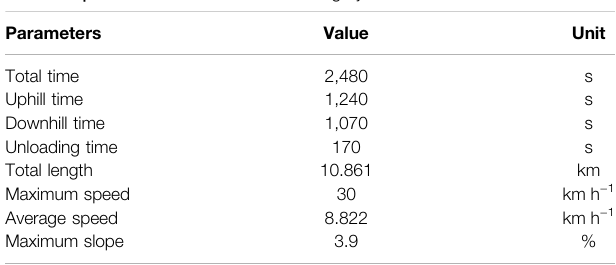
TABLE 2 | Parameters of the actual working cycle.